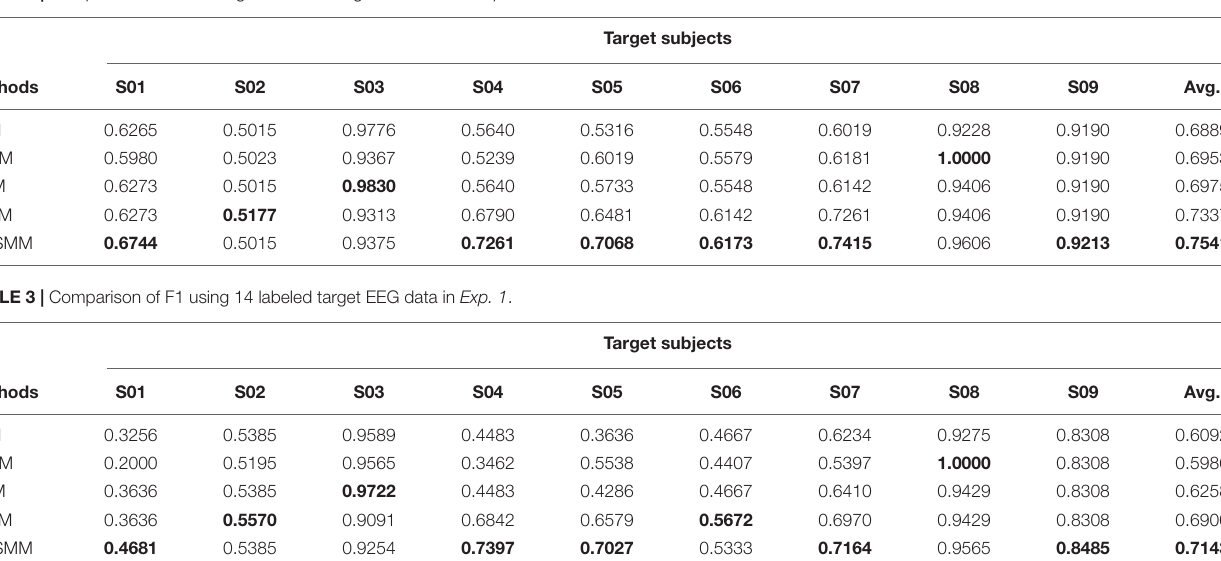
TABLE 2 | Comparison of AUC using 14 labeled target EEG data in Exp.1 .